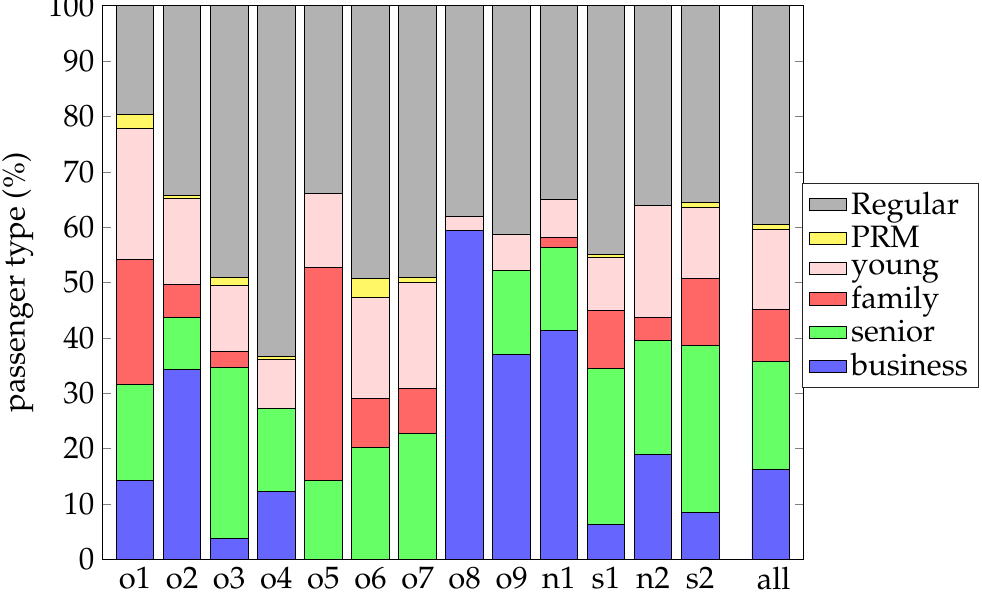
Figure 2. The distribution of passenger types for the 13 different security checkpoint